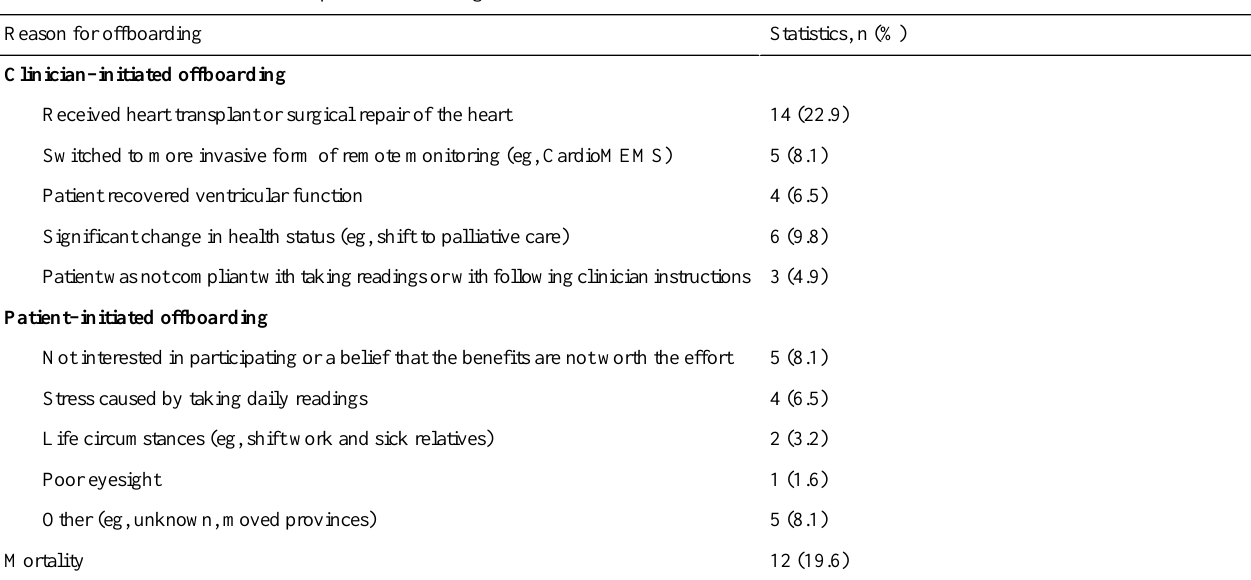
Table 4. Classification of reasons for patient